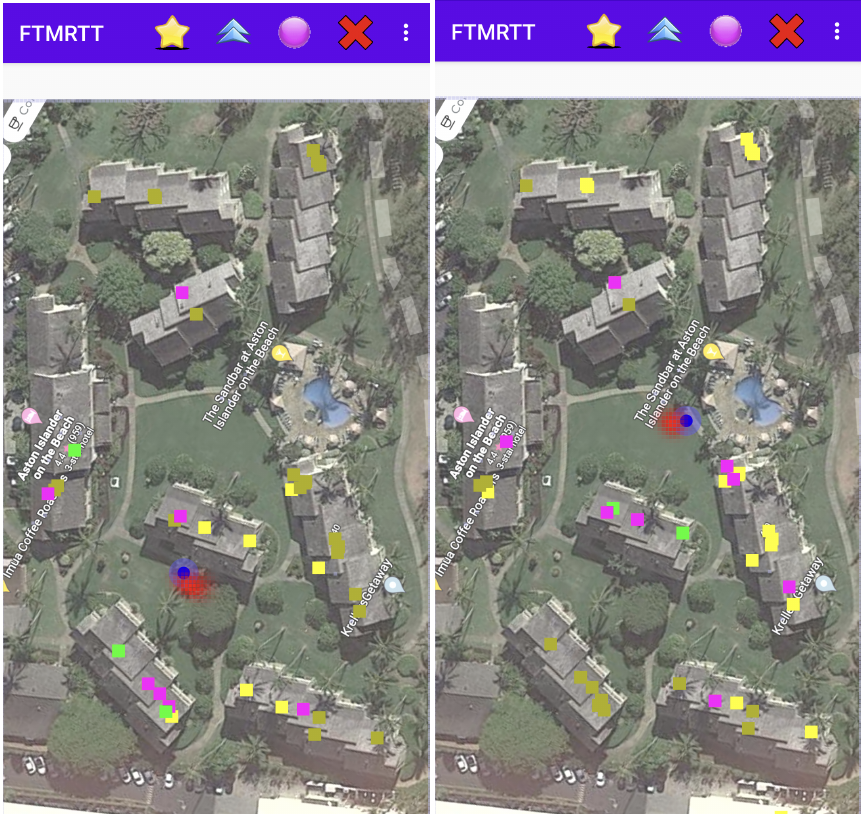
Figure 8. Two sample screenshots of the FTMRTT application using the Bayesian grid update method as a “heat map”. The “hot spot” (red) is the area of high probability. The blue spot is the GPS estimate. APs currently responding to ranging requests are shown as green squares. APs in the current selection not responding are shown in magenta. APs not in the current selection, but whose frequency and bandwidth are known are shown in